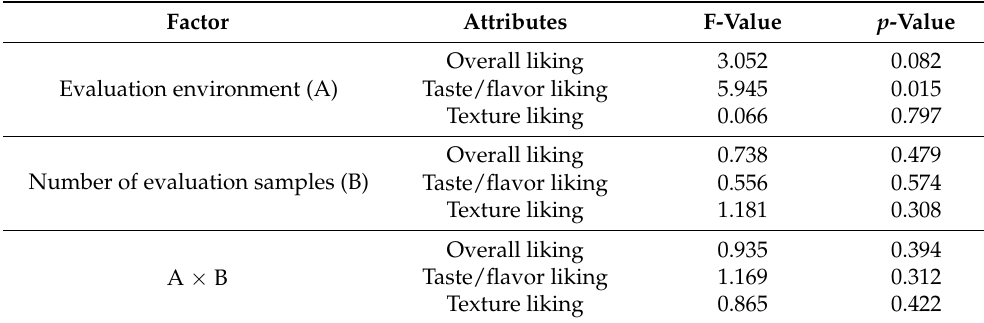
Table 3. Effect of the evaluation environment and the number of evaluation samples on the liking ratings for the almond beverage test target